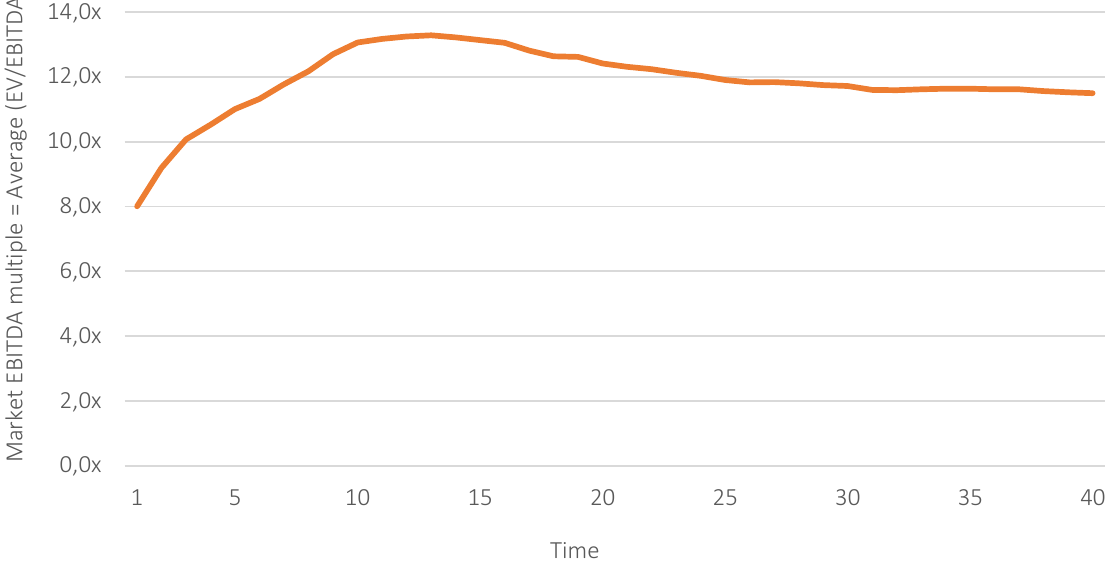
Figure 13. Market Ebitda multiple evolution in an Islamic LBO